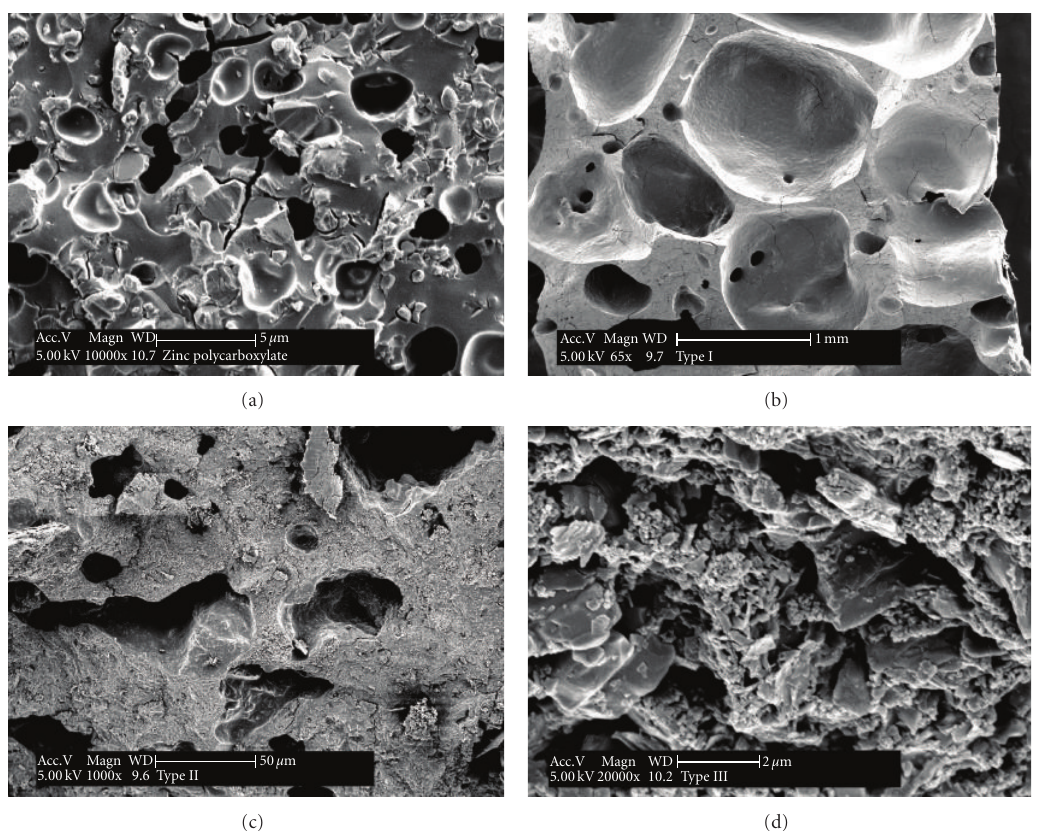
Figure 7: SEM microphotograph of the fractured surface of the four types of cements. (a) Zinc polycarboxylate cement; (b) Type I; (c) Type II; (d) Type III after